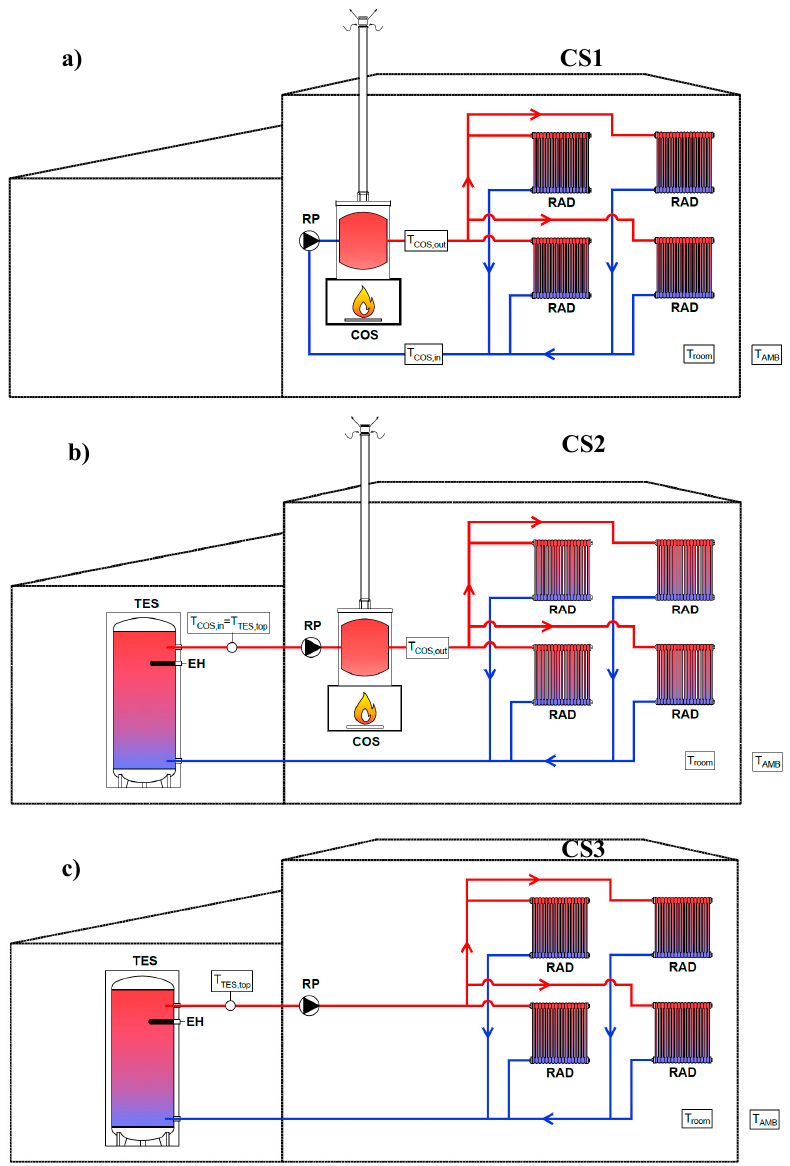
Figure 8. Schematics of the conventional heating system CS1 ( a ), the conventional heating system CS2 ( b ) and the conventional heating system CS3 ( c ). Table 7. The main control algorithms and strategies of the conventional heating systems CS1, CS2 and CS3.